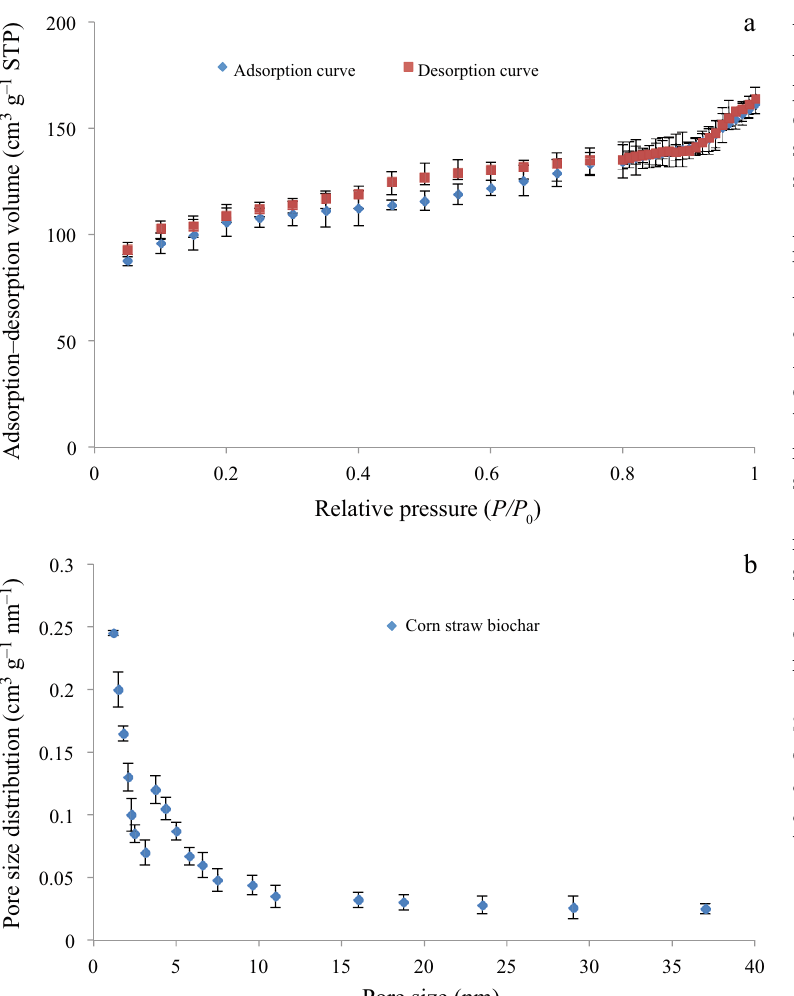
Fig. 1. SEM image of maize straw biochar at (a) 1000× and (b) 2500× magnification